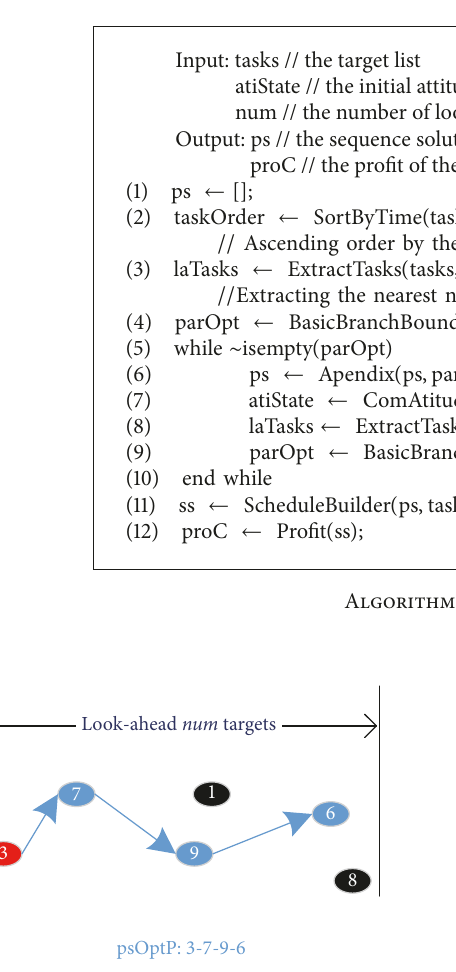
Figure 3: Look-ahead construction